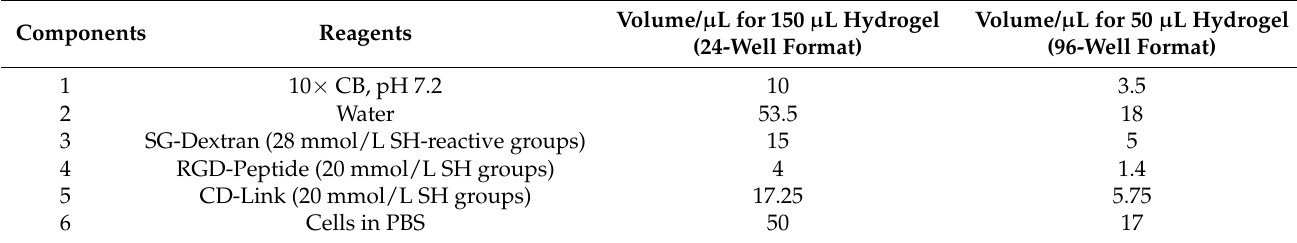
Table 1. Components and volumes for the preparation of the hydrogel